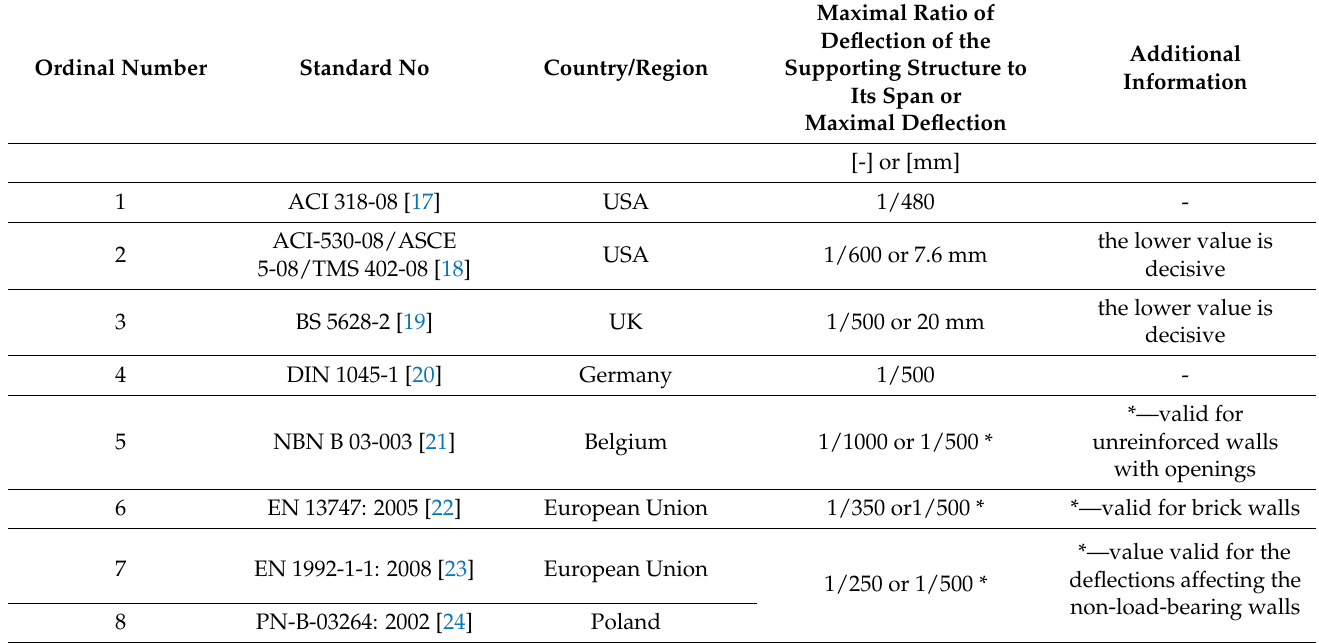
Table 2. Comparison of permissible deflection values of the supporting structure under partition